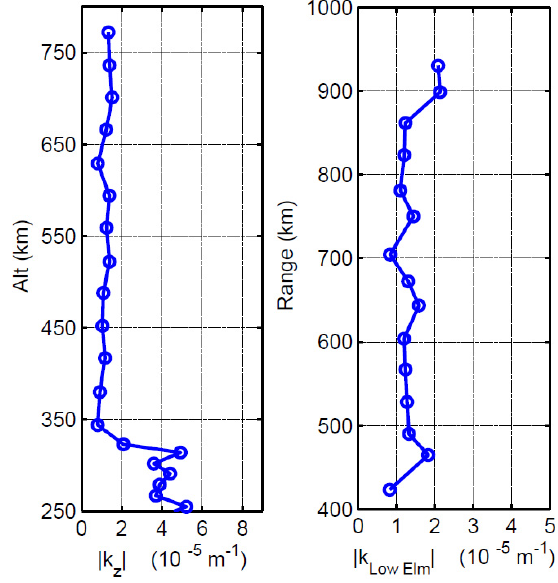
Fig. 7. Wave number components estimated along the two ESR radar beams using the method described by Ma et al. (1998), see text for details. The left-hand panel is for the field-aligned 42m dish and the right-hand side panel is for the low-elevation 32m dish.